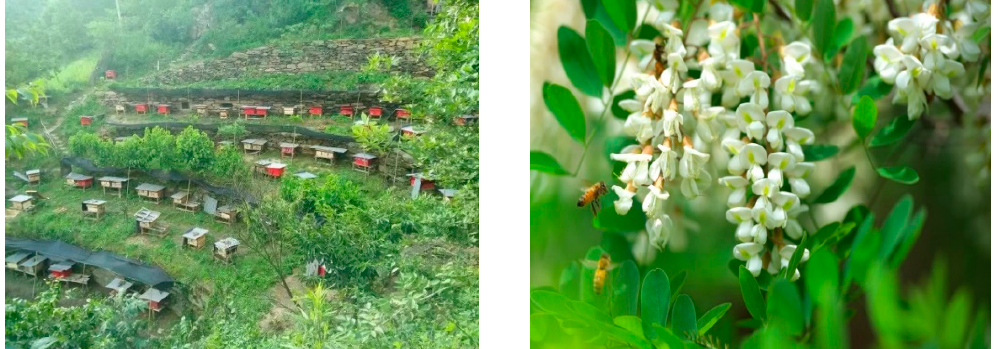
Figure 1. Photograph of mature honey demonstration basement and acacia tree flower.